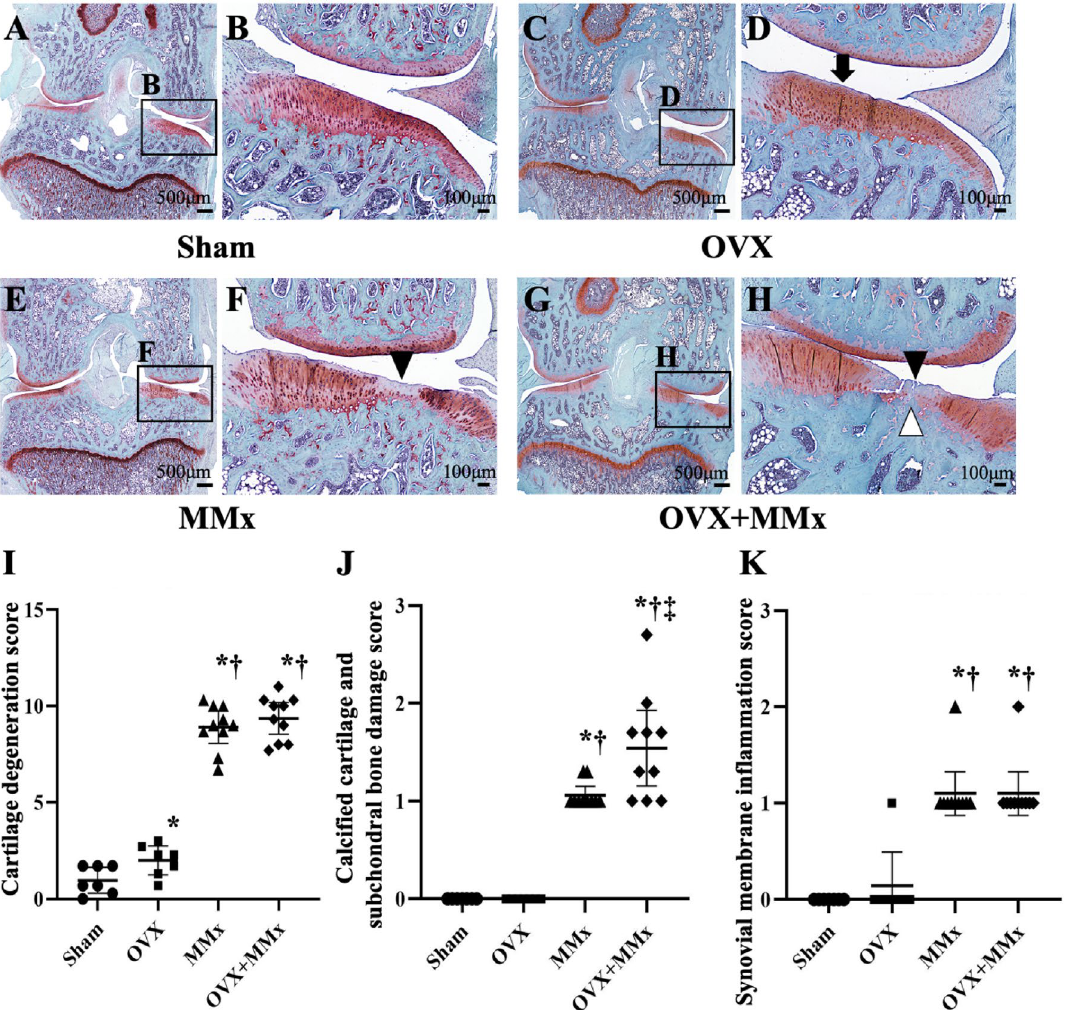
Figure 1. Histological analysis of cartilage degeneration. Histological findings of safranin-O/fast green staining in the Sham ( A , B ), OVX ( C , D ), MMx ( E , F ), and OVX + MMx ( G , H ) groups. Decreased safranin-O staining in the superficial layer of articular cartilage (arrow) was observed in the OVX group (D), and cartilage degeneration (black arrowhead) was observed in the MMx (F) and OVX + MMx (H) groups. Loss of tidemark integrity (white arrowhead) was observed in the OVX + MMx group (H). The right panels show higher magnification views of the boxed areas in the left panels. OARSI scores of each group ( I , J , K ). The calcified cartilage and subchondral bone damage scores of the OVX + MMx group were highest among the four groups (J). Lines represent the mean and 95% CIs. *: p < 0.05 compared with the Sham group; †: p < 0.05 compared with the OVX group; ‡: p < 0.05 compared with the MMx